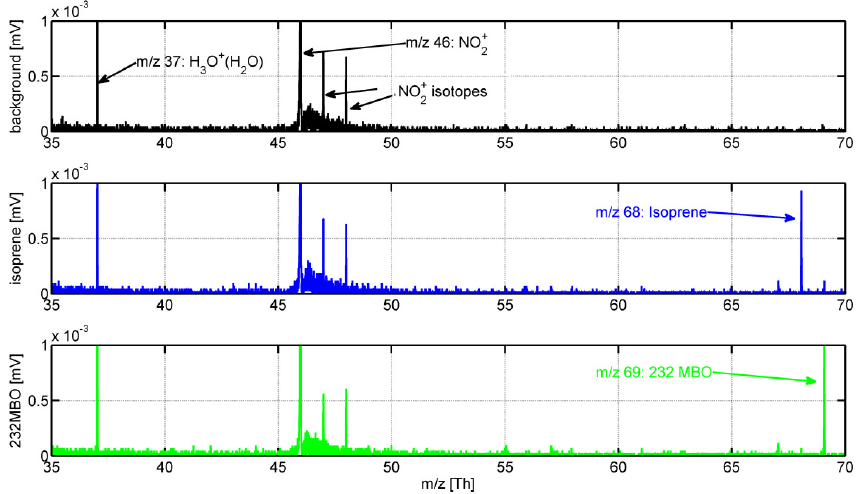
Fig. 1. Plot of the mass spectrum beween m/z 35 + Th and m/z 70 + Th for a blank (top panel), an isoprene standard (middle panel) and 232MBO standard (lower panel). Ion impurities are labelled on the top panel.